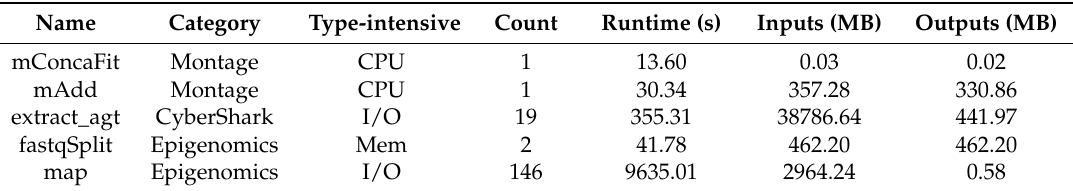
Table 1. Scientific workflow characteristics.